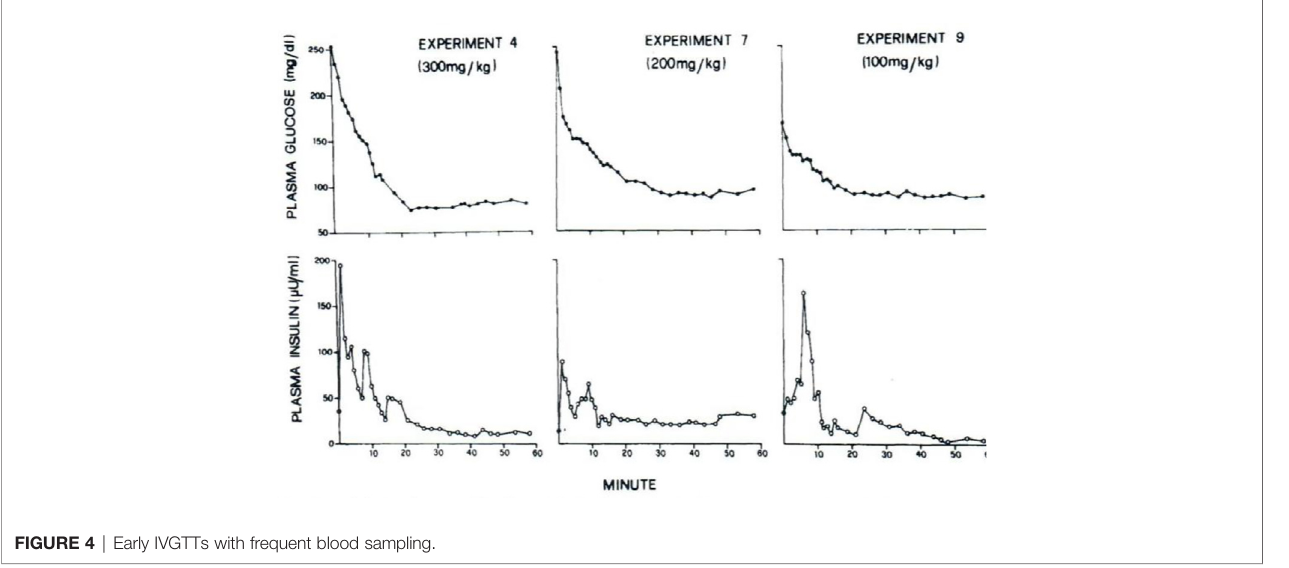
FIGURE 4 | Early IVGTTs with frequent blood sampling.